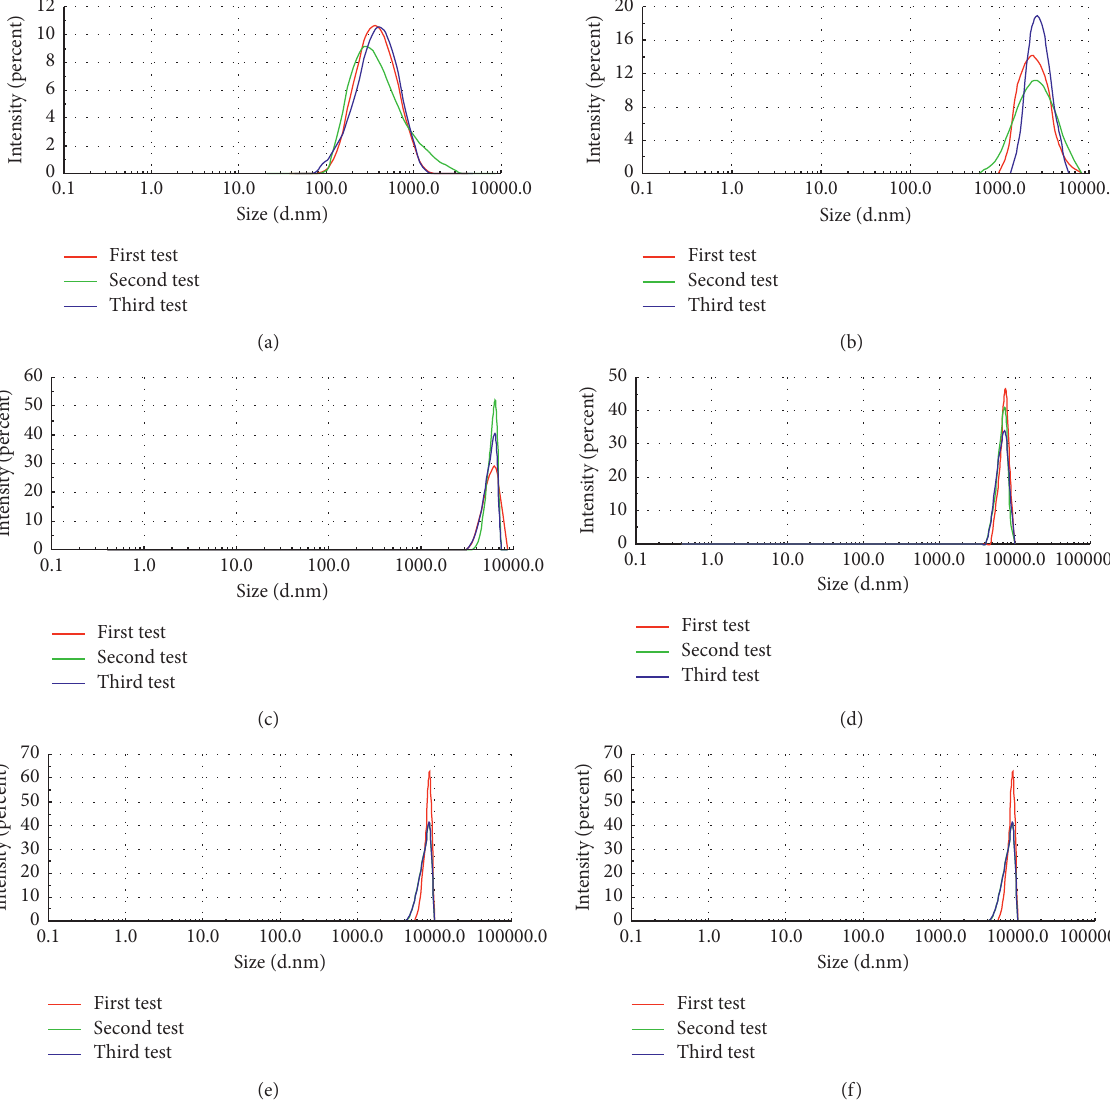
Figure 7: Size distribution diagram of the polymeric microsphere solutions over time. (a) Original size distribution of the polymeric microsphere solution. (b) Size distribution of the polymeric microsphere solution after aging for 1d. (c) Size distribution of the polymeric microsphere solution after aging for 5d. (d) Size distribution of the polymeric microsphere solution after aging for 10d. (e) Size distribution of the polymeric microsphere solution after aging for 15d. (f) Size distribution of the polymeric microsphere solution after aging for 20d.